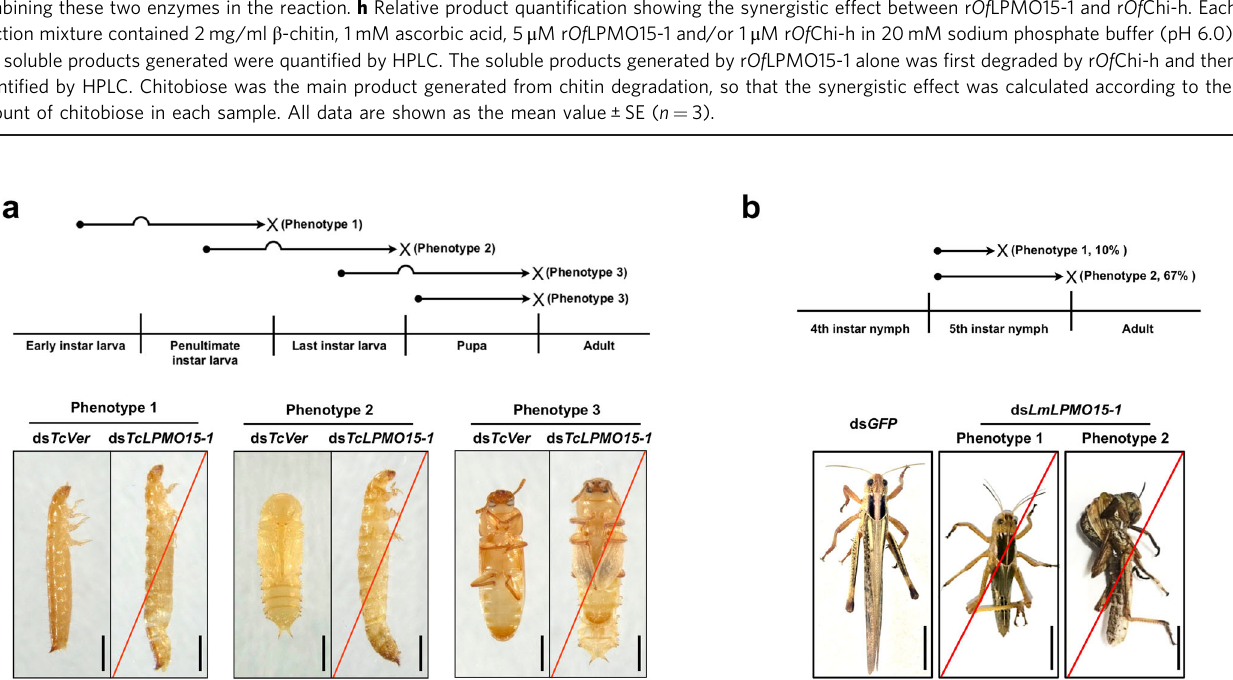
Fig. 4 Lethal phenotypes produced by RNAi for LPMO15-1 in T. castaneum and L. migratoria . a In T. castaneum , injection of ds TcLPMO15-1 (200 ng per insect) into early instar, penultimate and last instar larvae had no effect on their subsequent molts and the resulting insects developed normally. However, they failed to undergo penultimate-last instar larval (Phenotype 1, n = 120), larval-pupal (Phenotype 2, n = 120) and pupal-adult (Phenotype 3, n = 120) molts, respectively, and died entrapped in their exuviae (red lines). A similar pupal-adult molting defect ( n = 60) was also obtained when ds TcLPMO15-1 was injected into day 0 pupae. Scale bar = 1 mm. b In L. migratoria , injection of ds LmLPMO15-1 (10 µ g per insect; injected twice) into 5th instar day 1 ( fi rst injection) and day 3 (second injection) nymphs resulted in developmental arrest and death (red lines) without dorsal splitting (Phenotype 1, ∼ 10%, n = 3) or exhibiting a dorsal splitting during the molt but entrapped in their nymphal cuticle (Phenotype 2, ∼ 70%, n = 20). Scale bar = 1 cuticles of Tc LPMO15-1-depleted T. castaneum , RNAi for LmLPMO15-1 yielded no obvious differences in thickness and morphology of either the horizontal laminae or vertical pore canals in the newly formed adult cuticle compared with that of the ds GFP -control (Fig. 6f, h and Supplementary Table 1). All of